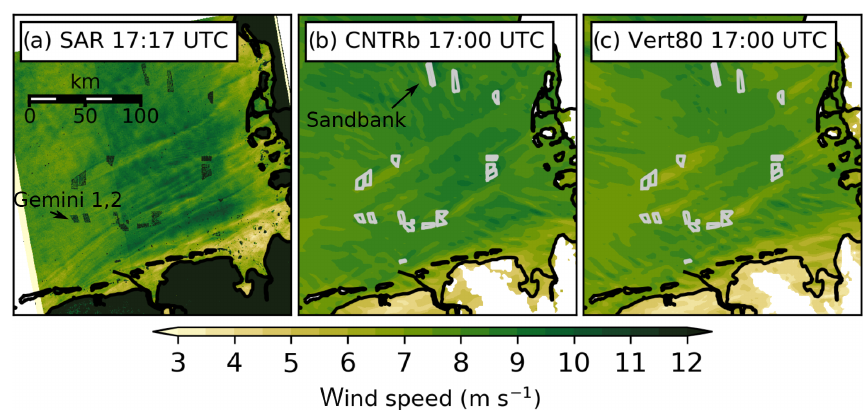
Figure 4. A comparison of SAR from Copernicus Sentinel-1A and WRF retrieved wind speed at 17:17 and 17:00UTC, respectively, on 14 October 2017 (case study II). The SAR data show the wind speed at 10m, whereas the model output is taken from the model level closest to 10m. Therefore, we show the wind speed at 17 and 15m for the CNTR and Vert80 simulations, respectively. The grayish polygons (b–c) denote the locations of the wind farms. Table 2. Overview of performed numerical simulations and parameter choices for the sensitivity experiments. Simulation Horiz. grid size Vertical TKE TKE Thrust Case (km) levels source advection coefficient study